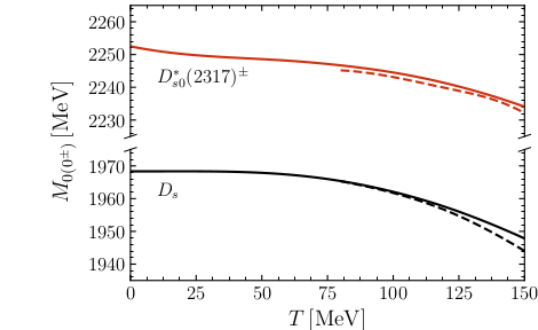
Figure 5: Thermal masses of chiral partners in the D -meson sector. Left: S = 0 ( 2300 ) resonance (double pole). Right: S = 1 channel with the D meson and the D ∗ 0 ( 2317 ) bound state. Figure taken from [ 16 ] channel with the D meson and the D ∗ s s 0